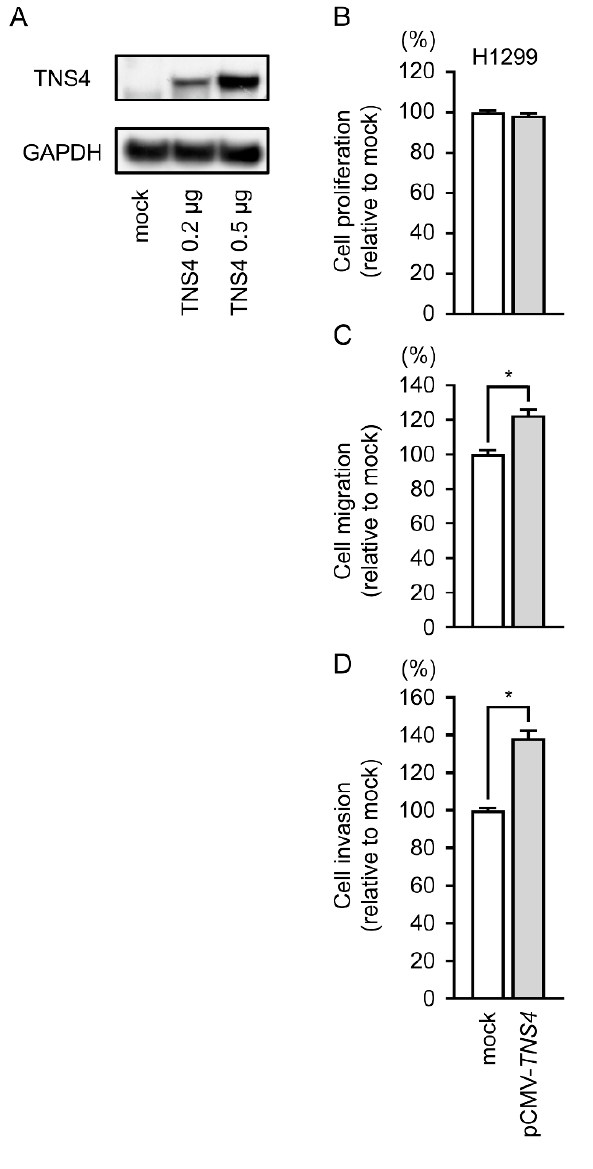
Table 4. Candidate downstream genes modulated by TNS4 in lung adenocarcinoma. Entrez